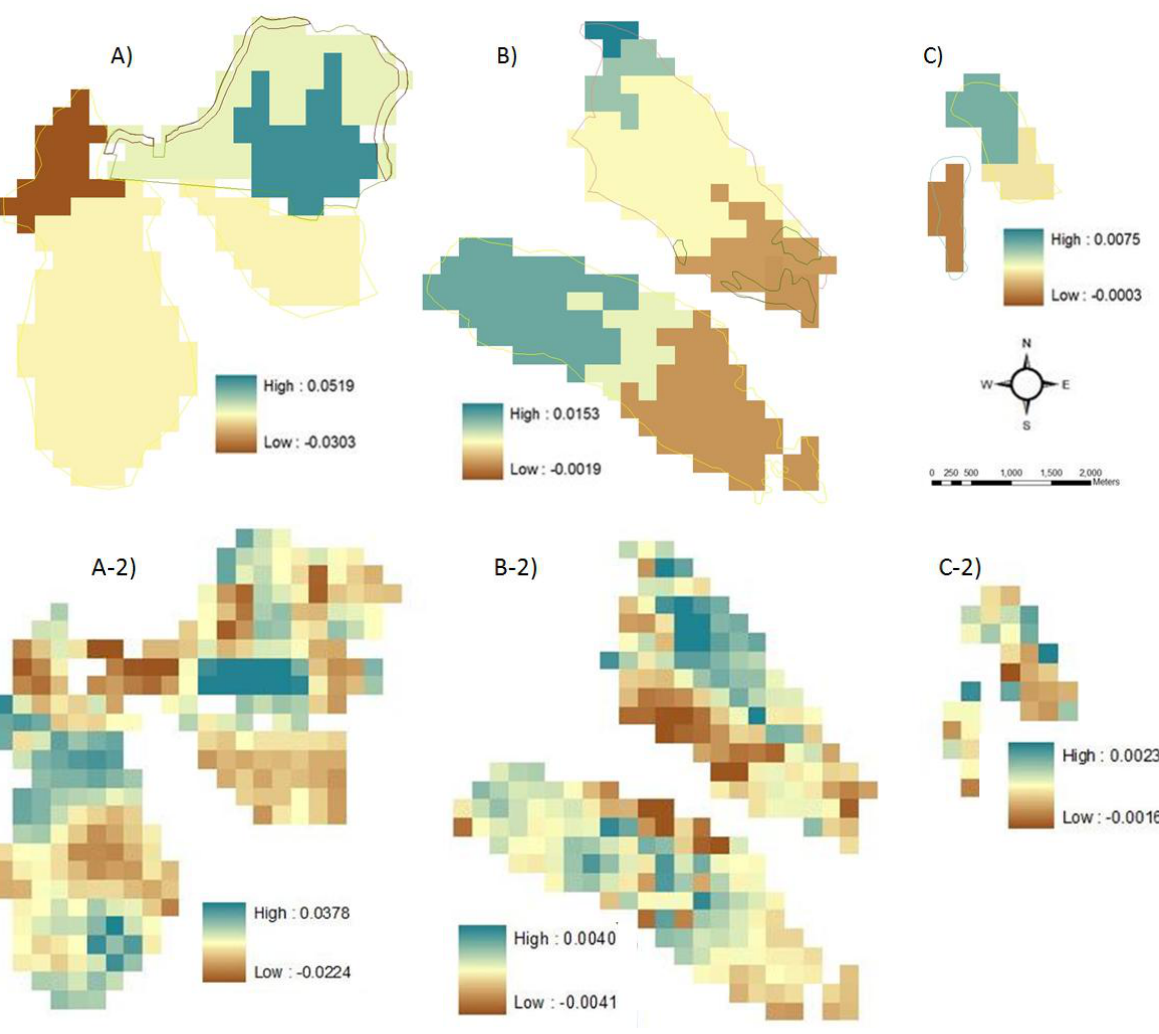
Figure 9. The CART spatial interpretation for the model results for trends in monsoon NDVI are shown in Frijoles Canyon ( A ), Mid Elevation Mesas ( B ) and Capulin ( C ). The figures A-2, B-2 and C-2 show the difference of the values estimated for monsoon trend (Figure 6), minus the values estimated by the MLR